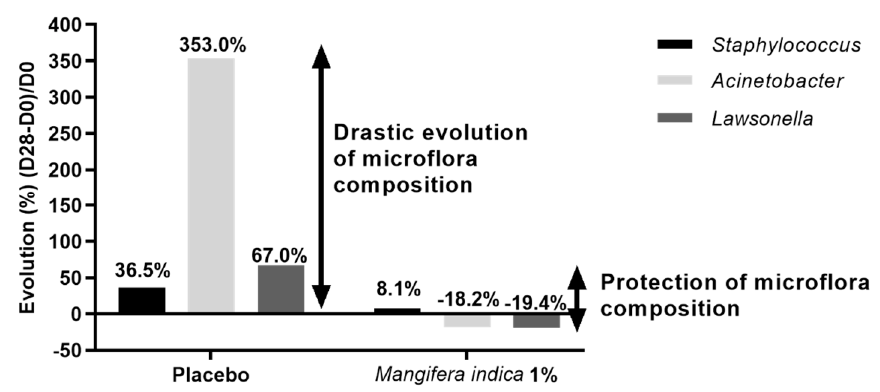
Figure 9. Representation of skin microbiota composition (analyzed by 16S rRNA sequencing) over time after application of placebo or M. indica extract at 1% after 28 days.